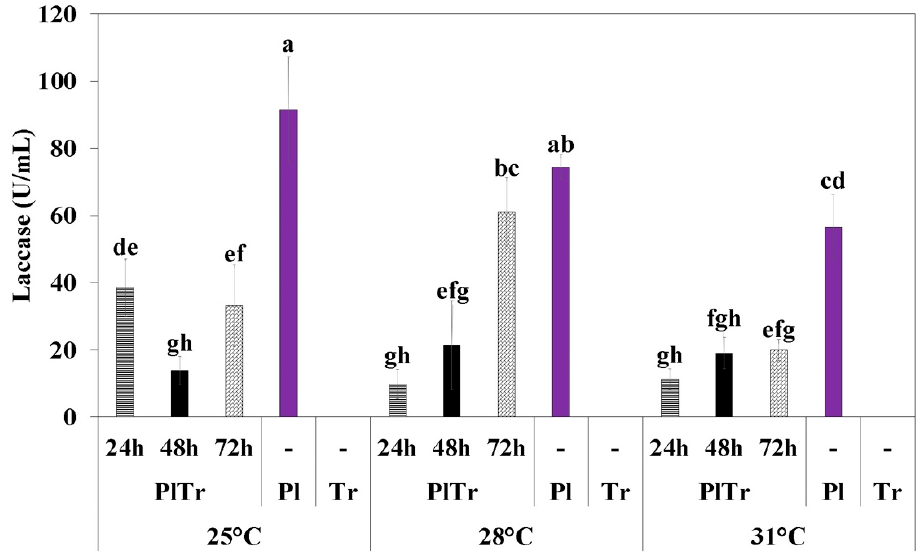
Figure 3. Enzymatic activities of laccases obtained in submerged fermentation using Mandels & Weber medium, with oil palm decanter cake (OPDC) as carbon source. The co-cultures were carried out by adding T. reesei (Tr) to 24, 48, and 72 h monocultures of P. lecomtei (Pl). The experiments were carried out at three different temperatures, 25, 28, and 31 °C, for 8 days. The monocultures of T. reesei and P. lecomtei were used as controls. Different letters over the bars mean significant differences ( p < 0.05) according to the Tukey test.